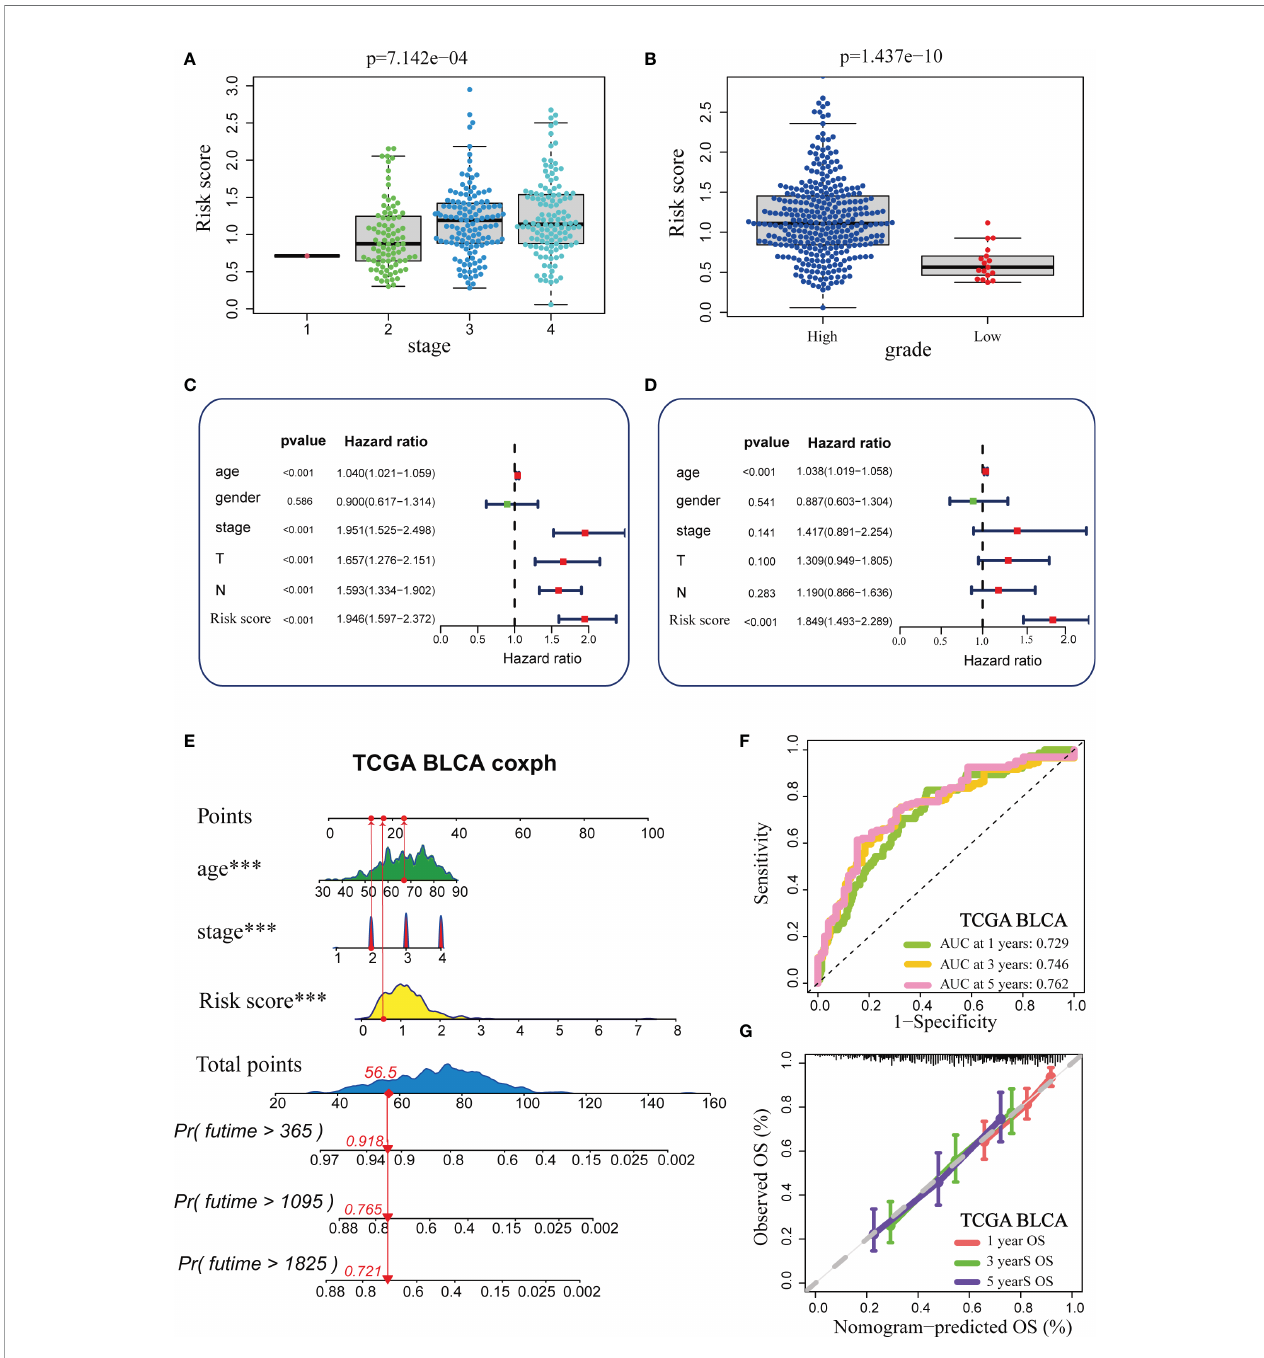
FIGURE 2 | Construction and validation of a comprehensive nomogram in the TCGA-BLCA cohort. (A, B) Relationships between TGF- b risk score, tumour stage, and tumour grade in the TCGA-BLCA cohort. (C, D) Results of univariate and multivariate Cox analysis. (E) Development of the nomogram based on stage, age and TGF- b risk score. (F) The ROC curves of the nomogram. (G) The Calibration plots for the nomogram. (***P <